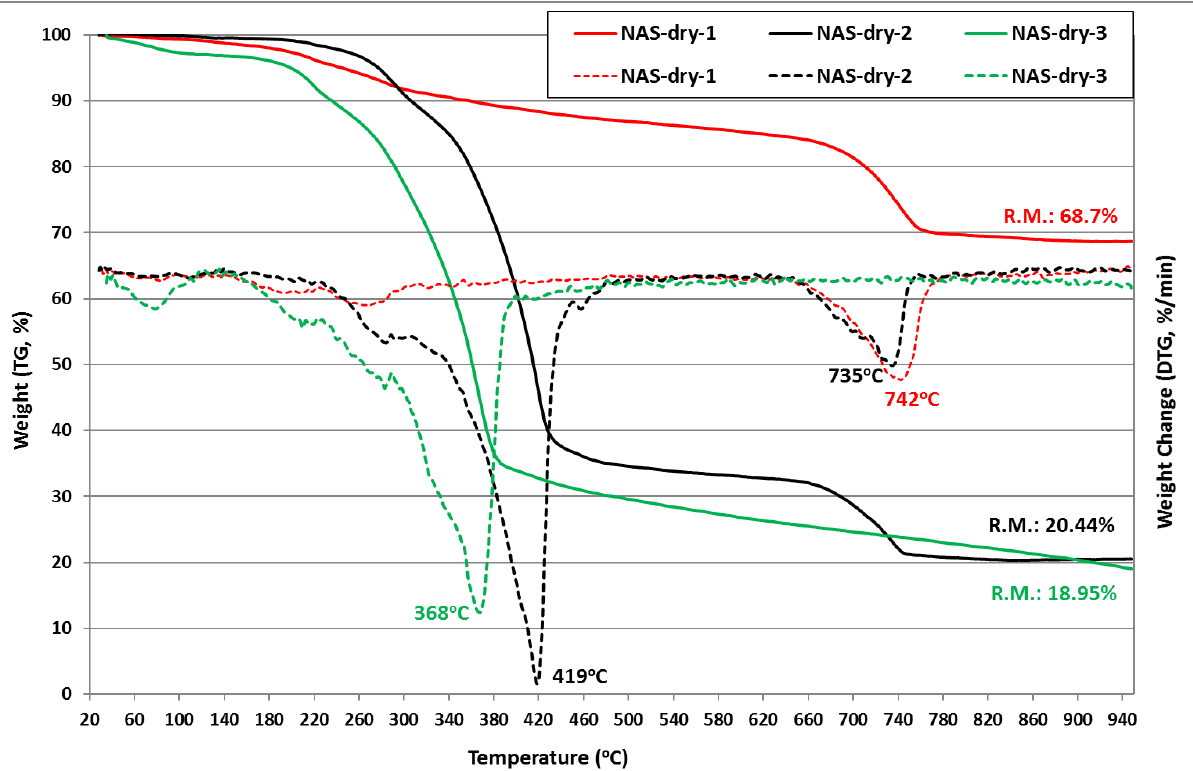
Figure 4. TGA/DTG curves of the three waste materials (in N 2 atmosphere).